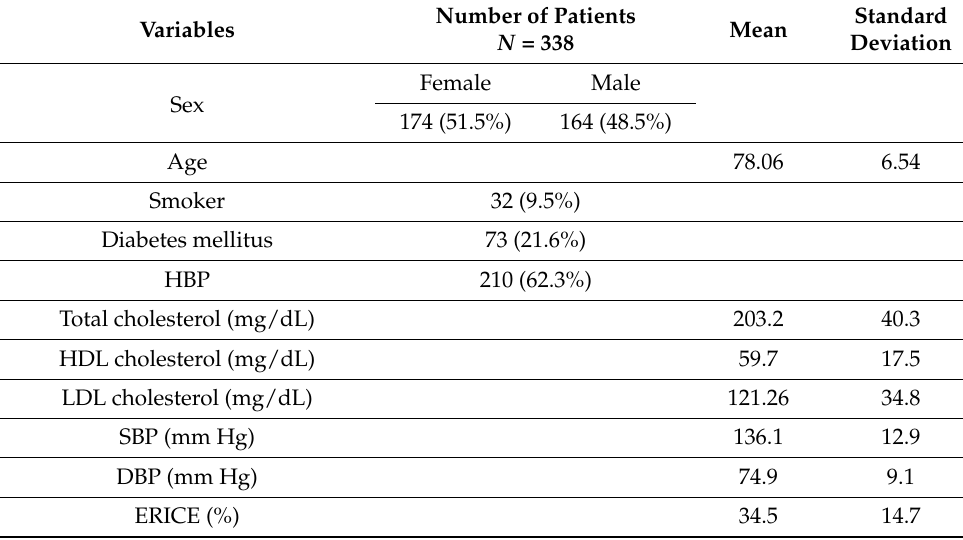
Table 1. Baseline characteristics and outcomes of the whole